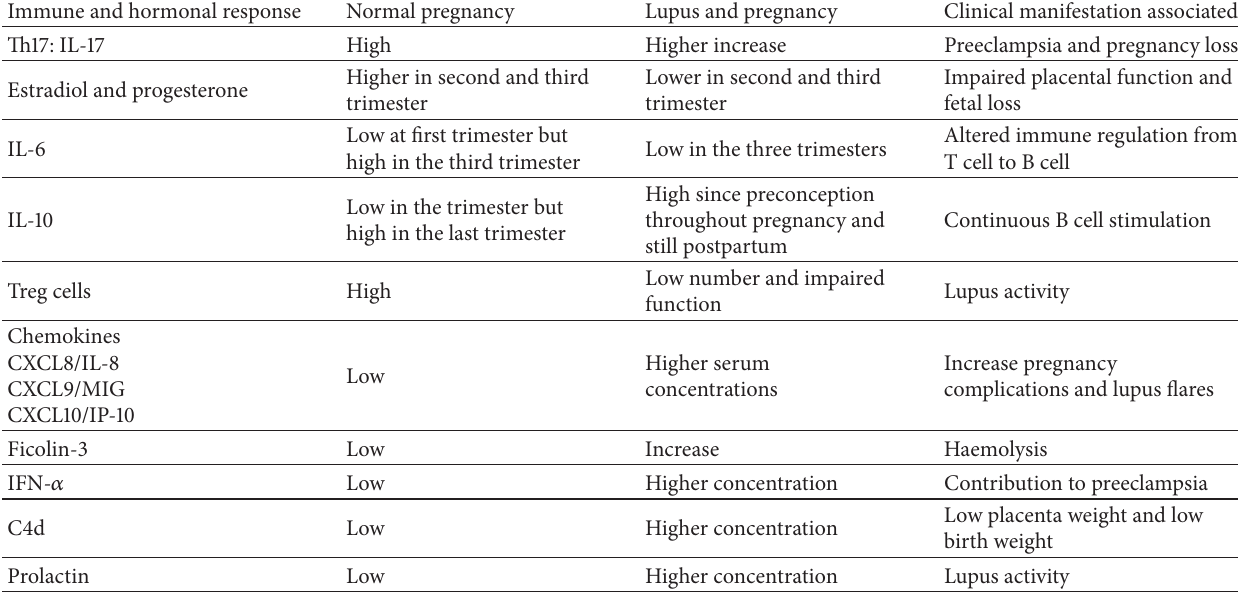
Table 1: Hormonal and immune response differences between normal pregnancies.